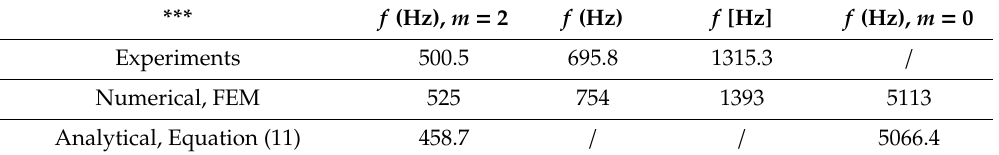
Table 4. Comparison of experimental, numerical and analytical results for the stator with